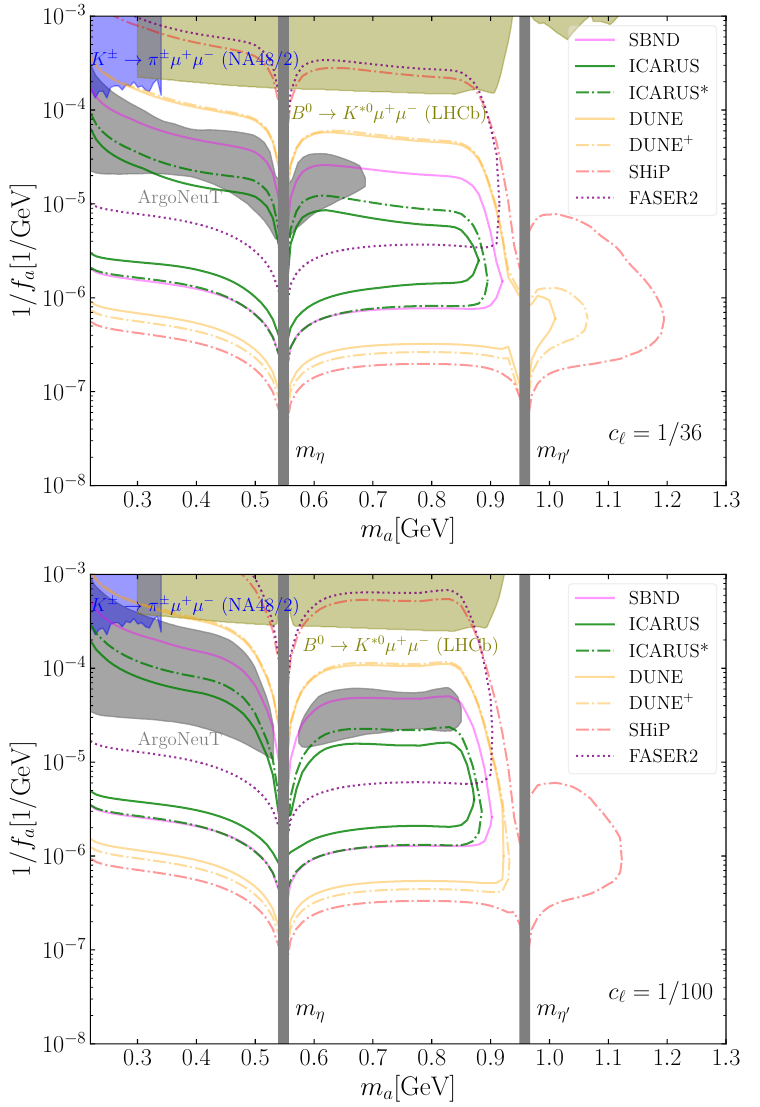
Figure 6 . Constraints (shaded-regions) and projections (curves) for c ‘ = 1 / 36 (upper panel) and c ‘ = 1 / 100 (lower panel). The curve labeled DUNE + denotes a scenario in which the axion can decay up to 30 m before the DUNE ND. The high-energy muons produced via these decays can still reach the detector. The curve labeled ICARUS ∗ is for the reach ICARUS would have through the off-axis NuMI beam. See text for more